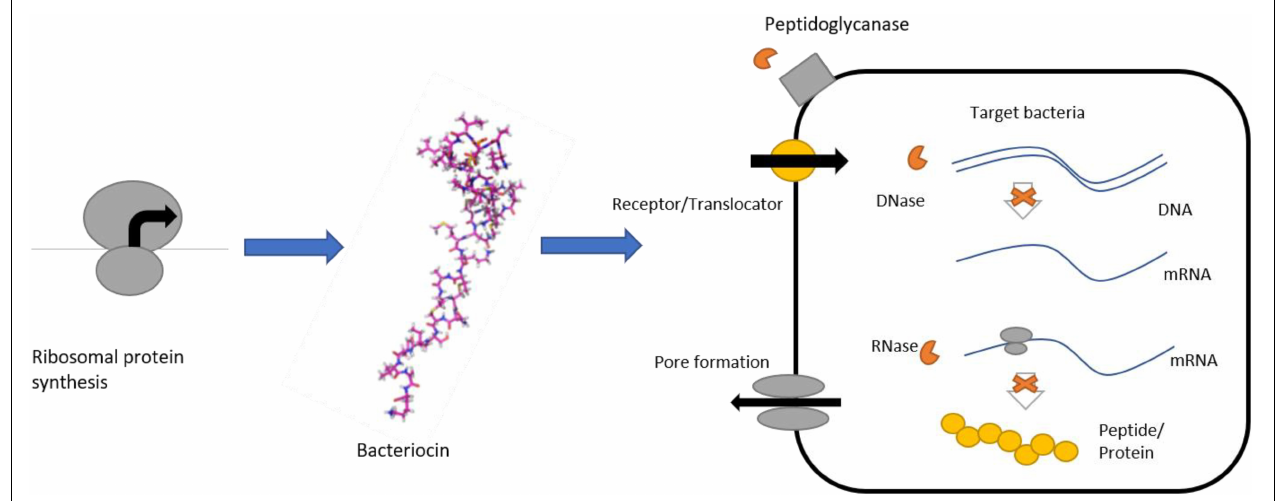
FIGURE 4 | Bacteriocin production and its antibacterial